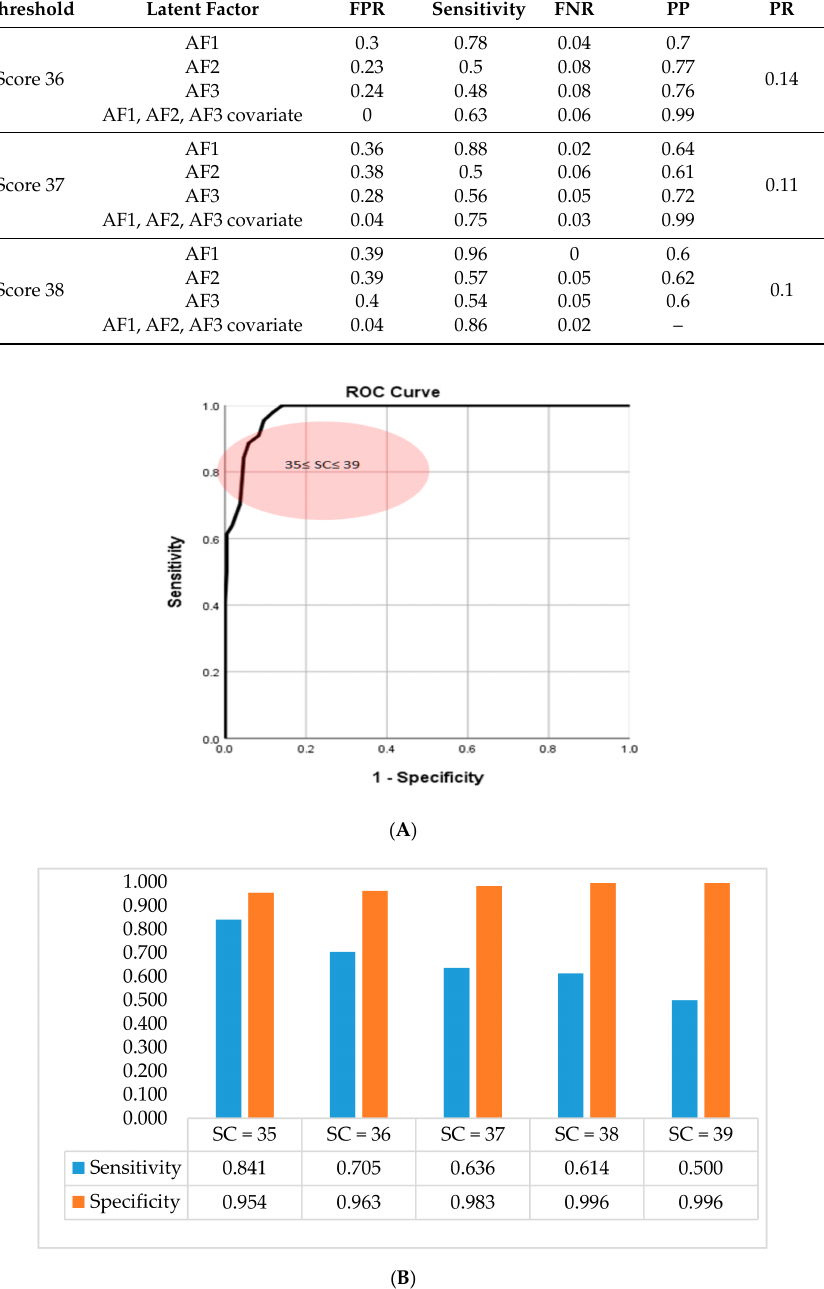
Figure 1. ( A ) The result of receiver operating characteristic curve (ROC) analysis shows the sensitivity (true positive) vs. 1-specificity (false positive rate) with the threshold severity score (SC) of the measure on the condition of cuto ff at 2.5 for the emotional latent factor. The area under the curve is 0.978 ± 0.007 between the lower bound of 0.964 and the upper bound0.992) with asymptotic significance 0.000 ( B ) It shows the association of threshold with sensitivity and the specificity by logistic regression model analysis and SC = severity